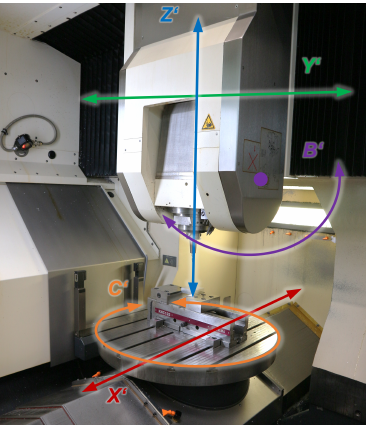
Figure 1. Machine tool kinematics of the 5-axis milling machine DMG Mori HSC 75